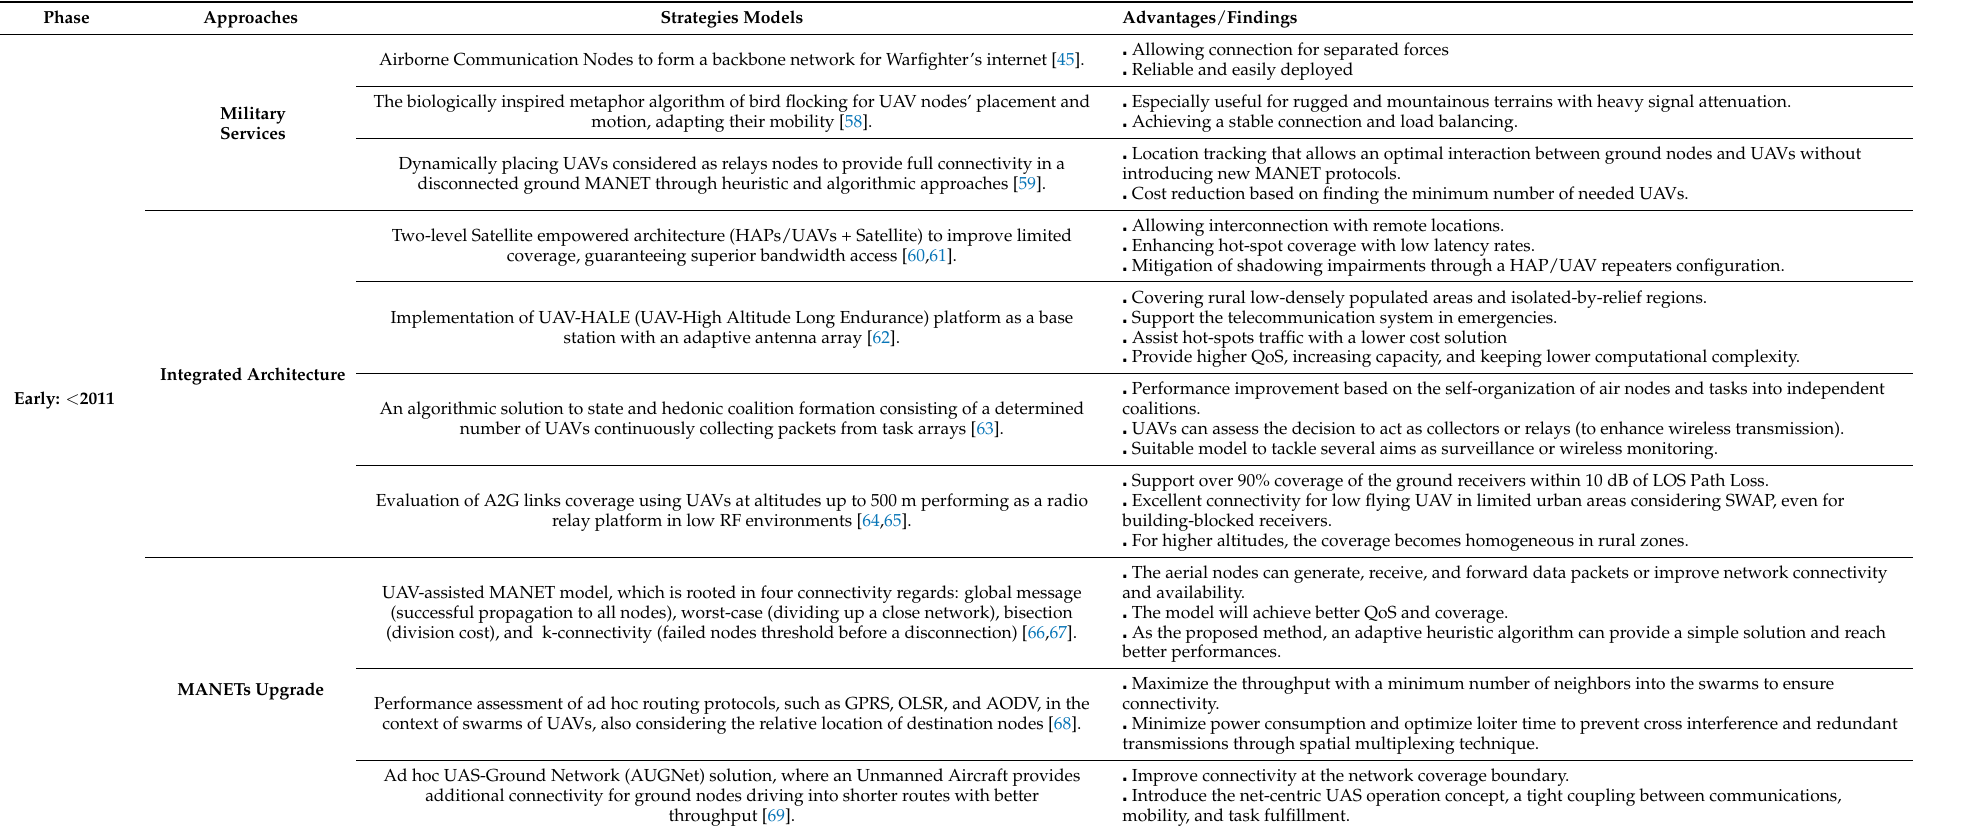
Table 4. Phases of UAV-based network